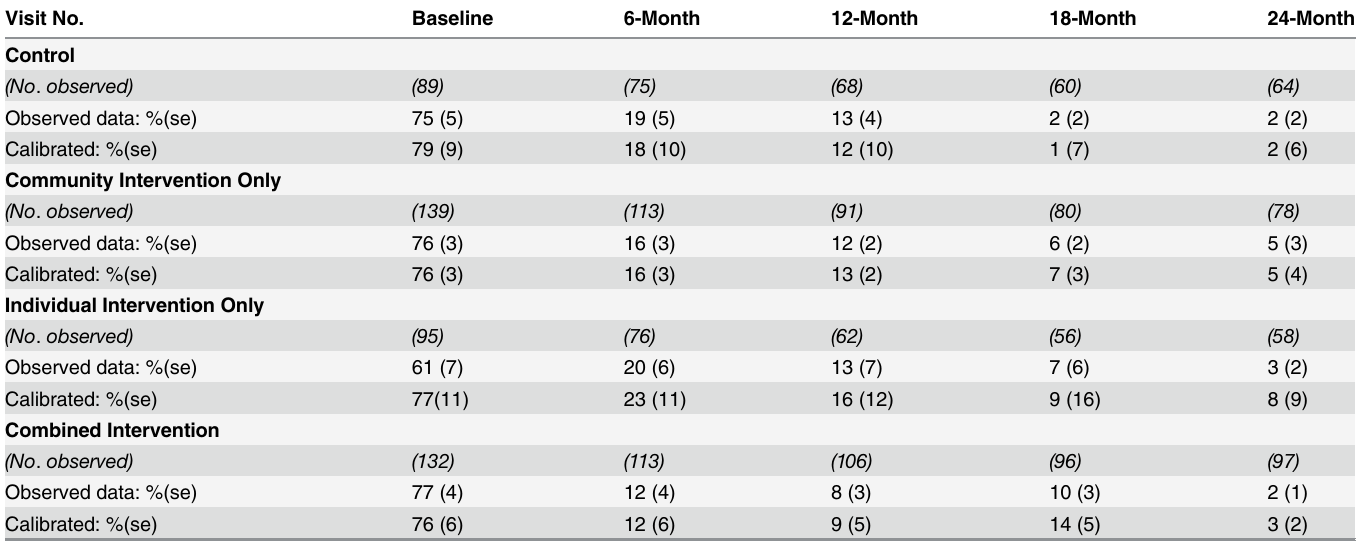
Table 3. Percent and standard error (se) of index participants who had shared any injecting needles, syringes or equipment in the past 3 months. Visit No.